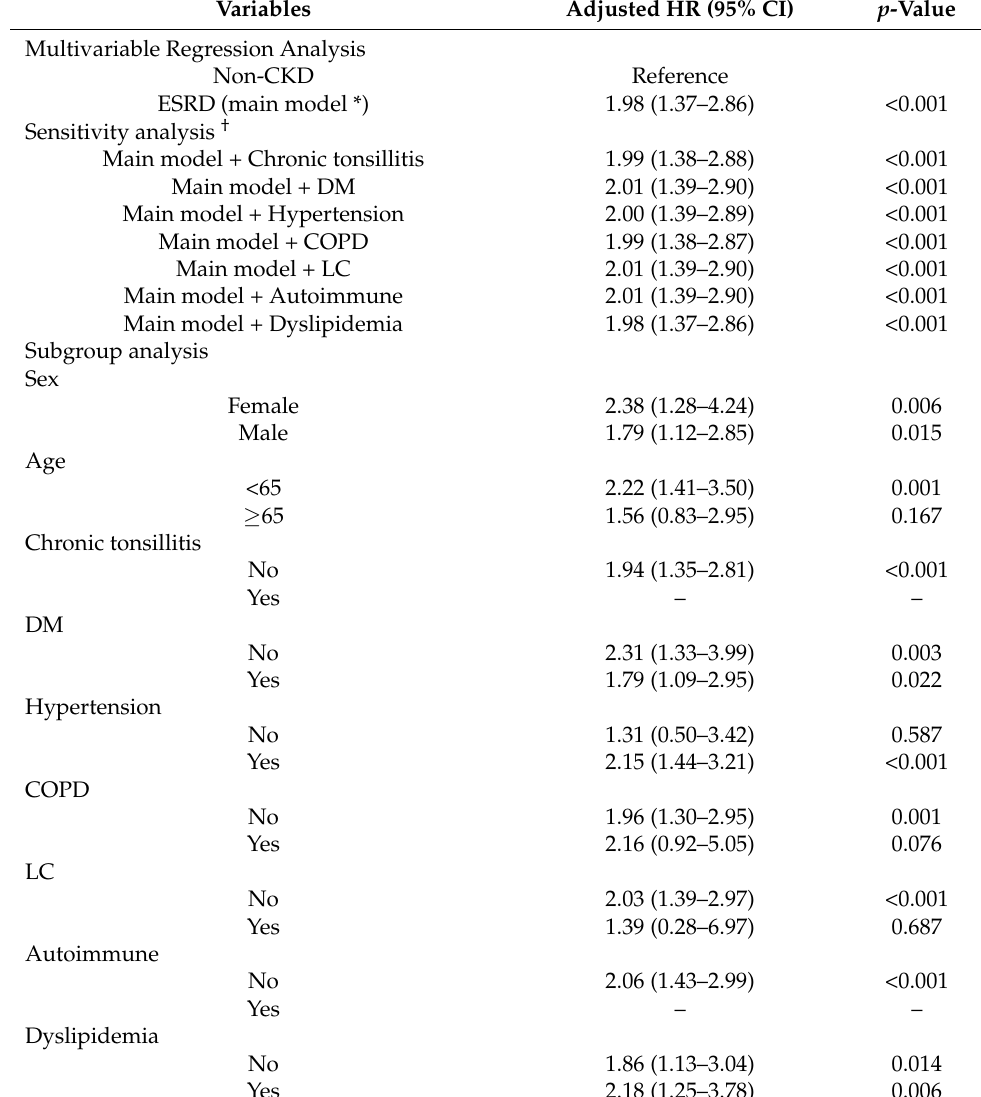
Table 3. Multivariable Cox proportional hazard regression for the association of ESRD with PTA and